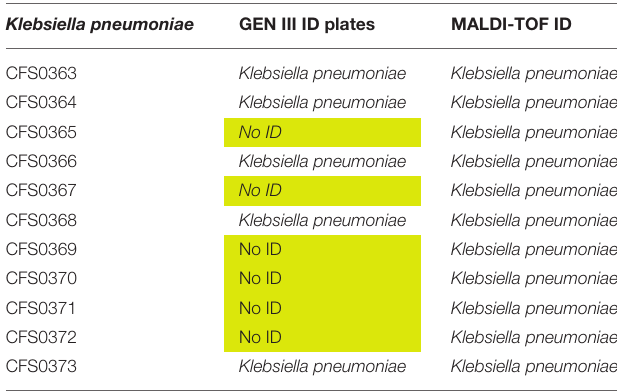
TABLE 1 | A table showing clinical isolates identified using both GEN III ID plates and MALDI-TOF MS spectra (see also Figures